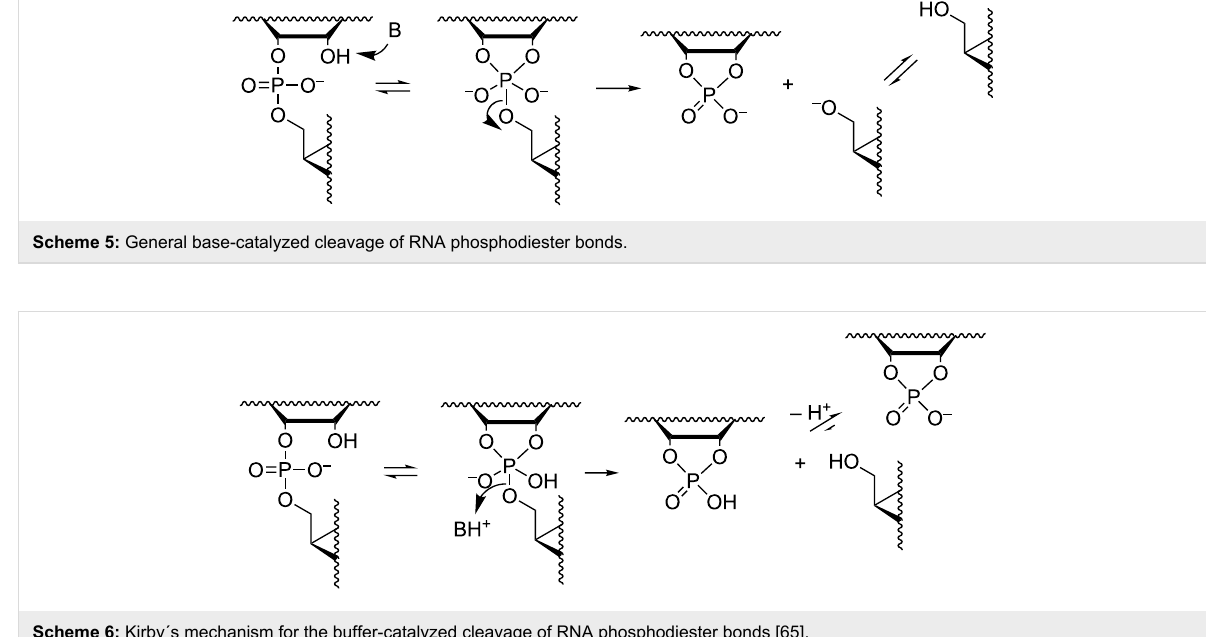
Scheme 6: Kirby´s mechanism for the buffer-catalyzed cleavage of RNA phosphodiester bonds